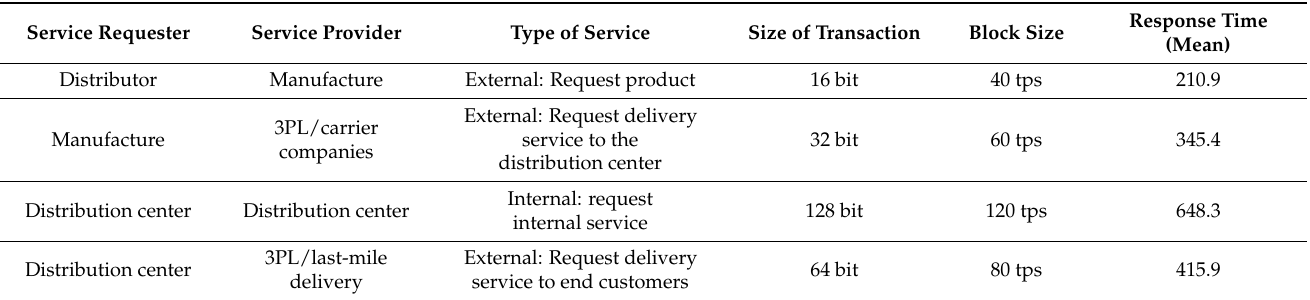
Table 3. Response time of the system.